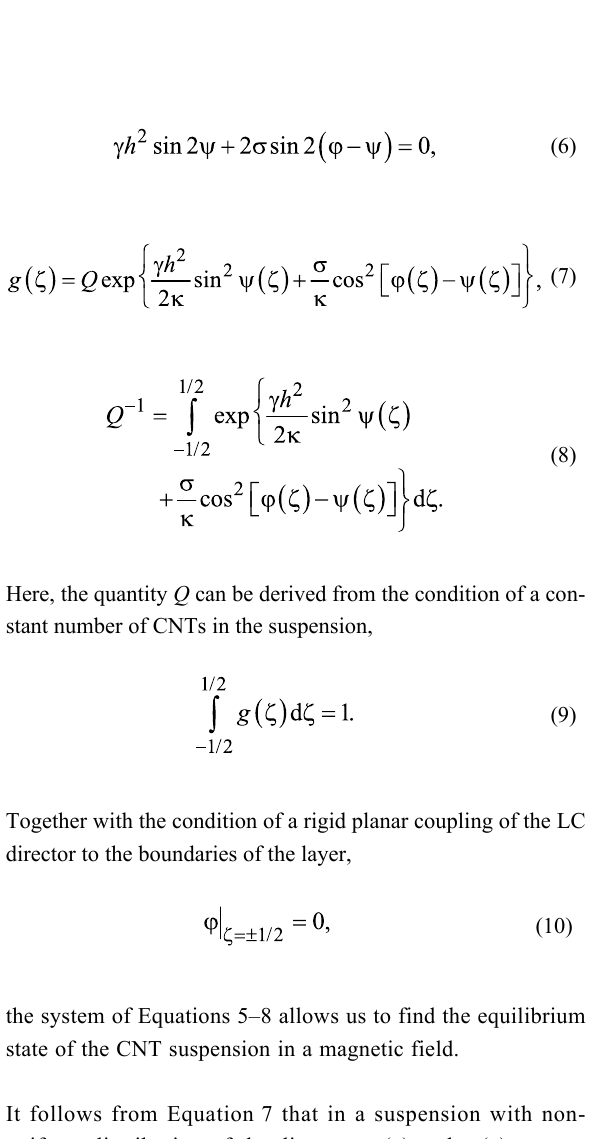
Figure 2: The structure of the orientational phases: (a) planar phase, (b) angular phase and (c) homeotropic phase.